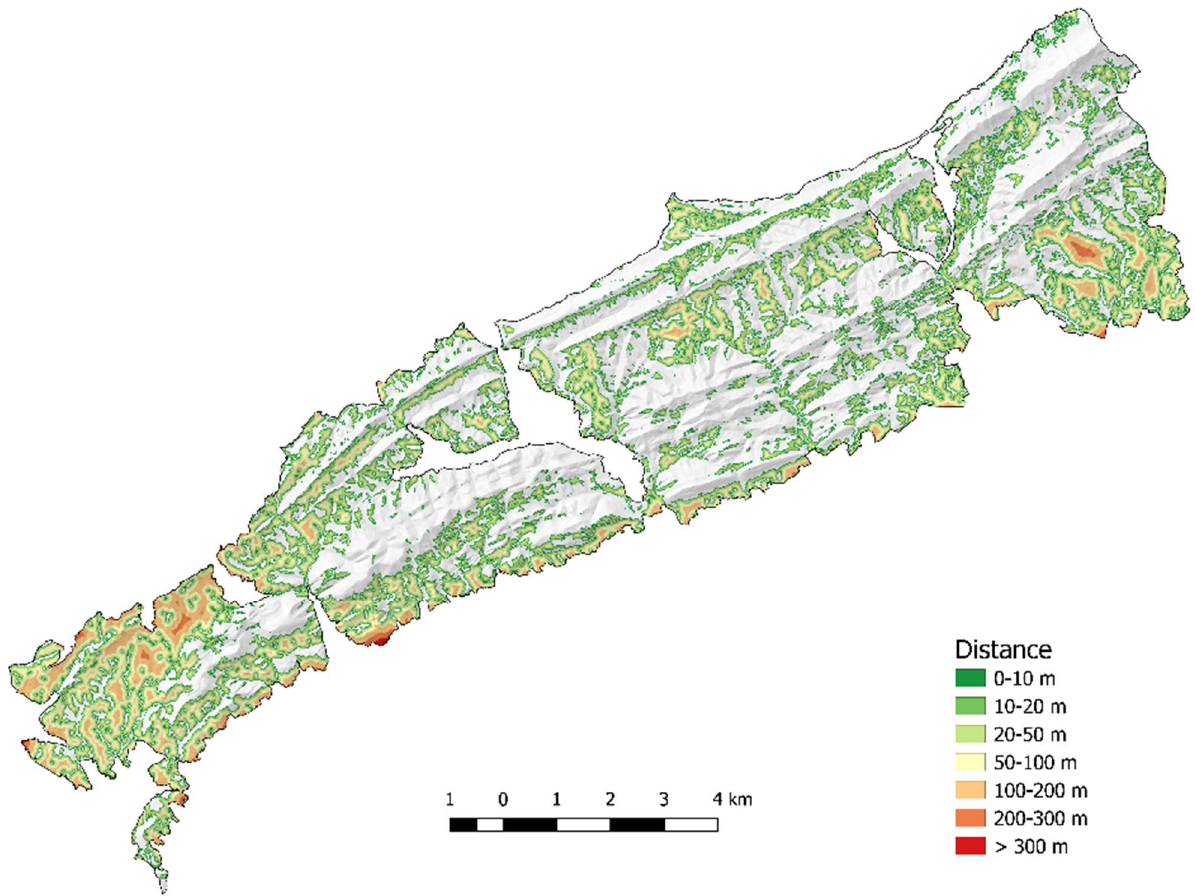
Formations, can also be found in the most extreme slopes, above 80%. The analysis of the